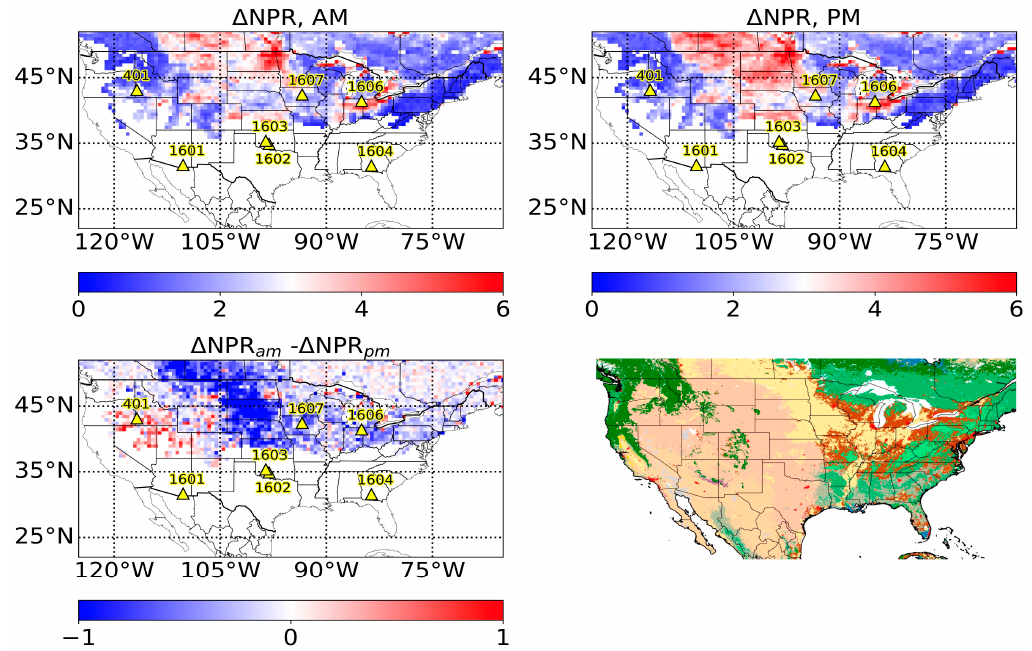
Figure 12. AM and PM dynamic range of NPR and their difference, subset to 2018 freeze extents obtained from January and February mean T eff being ≤ 273 K (Figure 10). Freeze (thaw) references (NPR fr , NPR th ) are obtained from the 5 lowest (highest) NPR values occurring during January and February (July and August). ∆ NPR(AM) is the dynamic range (e.g., for AM it is calculated from NPR th (AM)—NPR fr (AM), and ∆ NPR(AM)— ∆ NPR(PM)) is the diurnal difference of the dynamic range. The last panel is a reproduction of Figure 1, added here to facilitate comparison of ∆ NPR with CONUS land cover (forests are shown in green). The reader is referred to Figure 1 for the legend. For most of CONUS, the PM dynamic range is greater than the AM dynamic range (Figure 12). range is greater by about 1 (or ~25% assuming NPR AM = 4). The CVS results indicated that FT states determined from PM overpass data are about 5% more accurate than from AM data (Tables 4 and 5). This may be due to the larger PM dynamic range improving the STA [19].